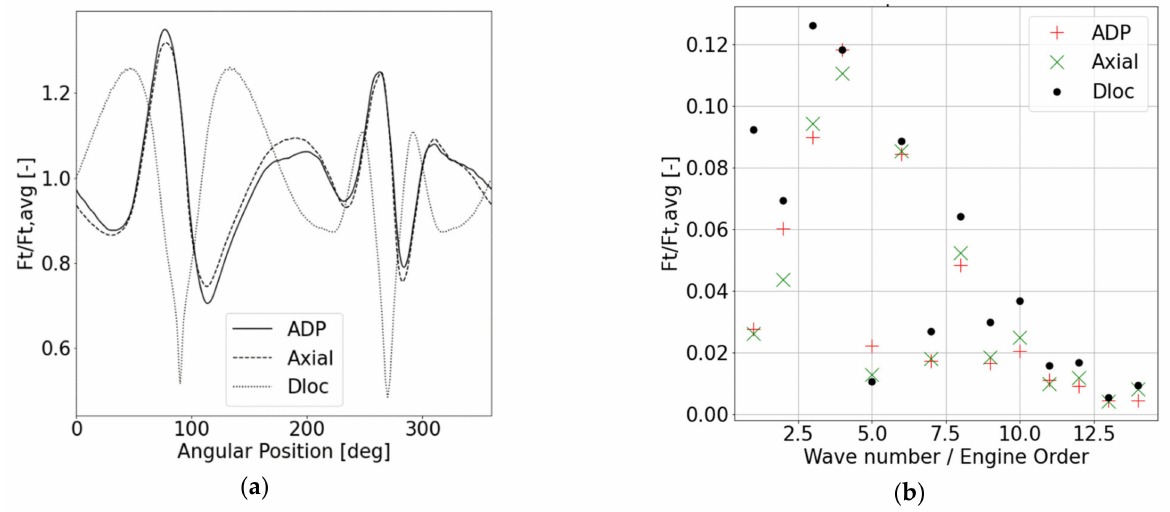
Figure 11. Blade forcing for ADP and Axial with reference distortion Dloc. ( a ) As a function circumferential position; ( b ) Fourier component